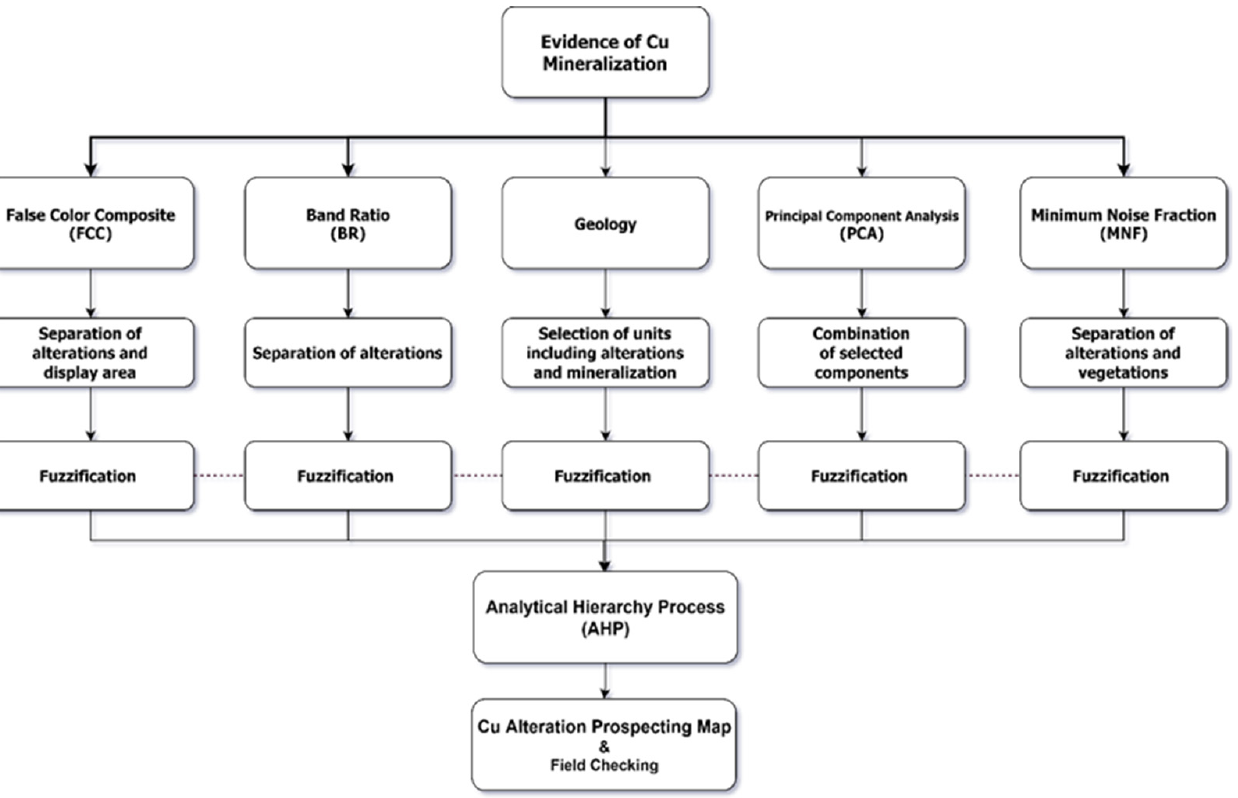
Figure 2. Hierarchical structure for modeling copper mineralization potential in Simorgh region.